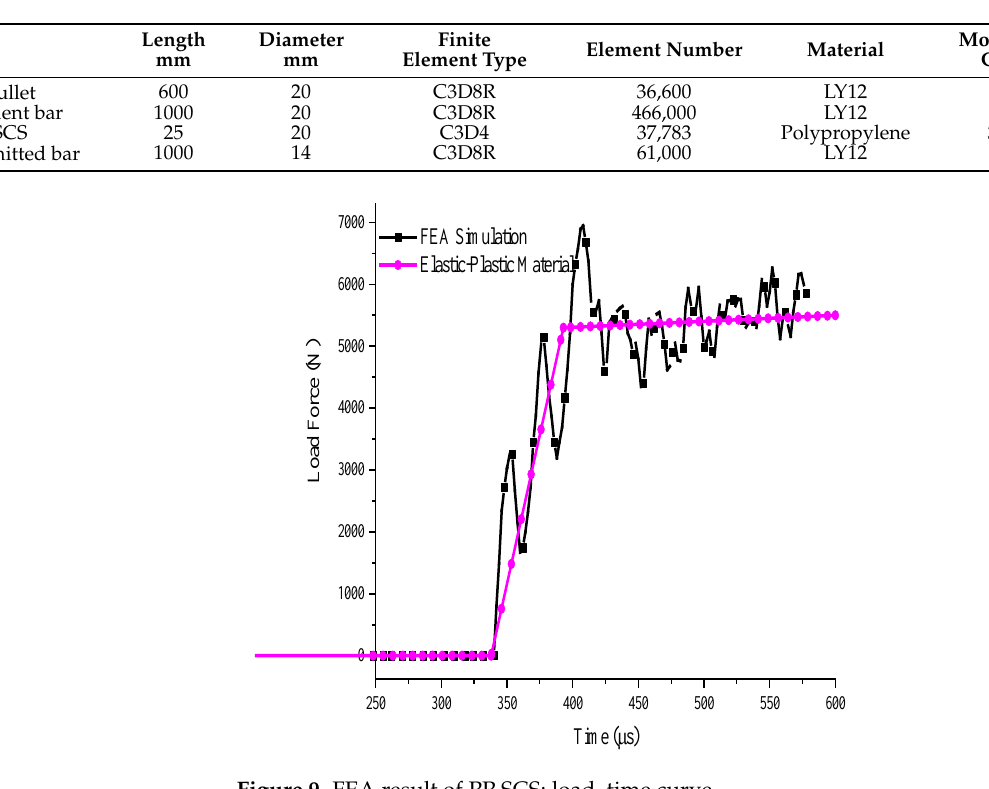
Figure 10. Effect of bullet length of 45° SCSs. As can be seen from Figure 10, the incident strain signals in the incident bar had roughly the same intensity in the two experiments. The signal response of the semicon- ductor strain gauge on the output bar was that the intensity of the signals in the transmis- sion bar dramatically decreased at the loading time of 120 us for a bullet with a length of 300 mm. This suggests that the arrival of the unloading wave at the position of the strain gauge was responsible for the decrease. For a bullet with a length of 600 mm at the same velocity, the intensity of the strain signals in the transmission bar underwent a dramatic decrease at the loading time of approximately 141 us. Since the pulse width of the stress loaded was 240 us, the possibility that the strain signal decrease in the transmission bar was caused by the unloading wave can be excluded, and therefore, it should be attributed to the occurrence of the yield or basic instability. In fact, in the dynamic compression ex-